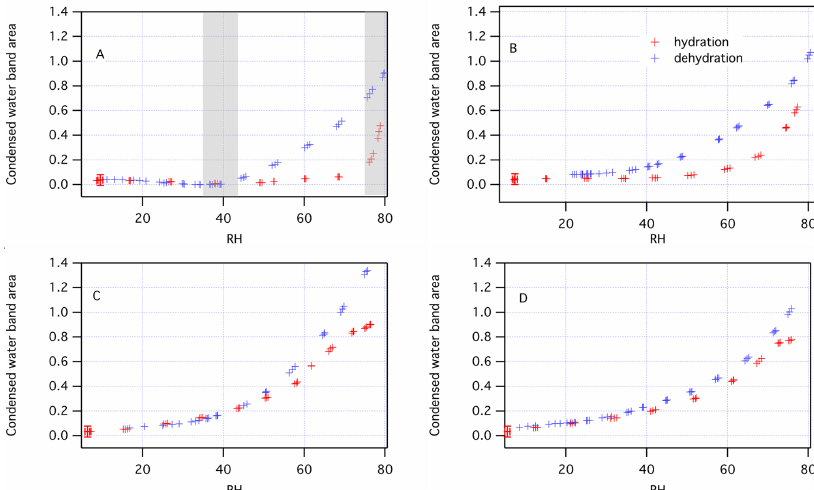
Figure 7. Deliquescence and efflorescence experiments on (NH 4 ) 2 SO 4 / glycerol/water ternary mixtures of variable concentrations. (a) Pure ammonium sulfate. Note, efflorescence at ∼ 35% RH, deliquescence at ∼ 80% RH. (b) 1 : 3 glycerol / (NH 4 ) 2 SO 4 . Note, no clear efflorescence or deliquescence points. (c) 1 : 2 glycerol/(NH 4 ) 2 SO 4 . Note, no clear efflorescence or deliquescence points (d) 1 : 1 glycerol / (NH 4 ) 2 SO 4 . Note, no clear efflorescence or deliquescence